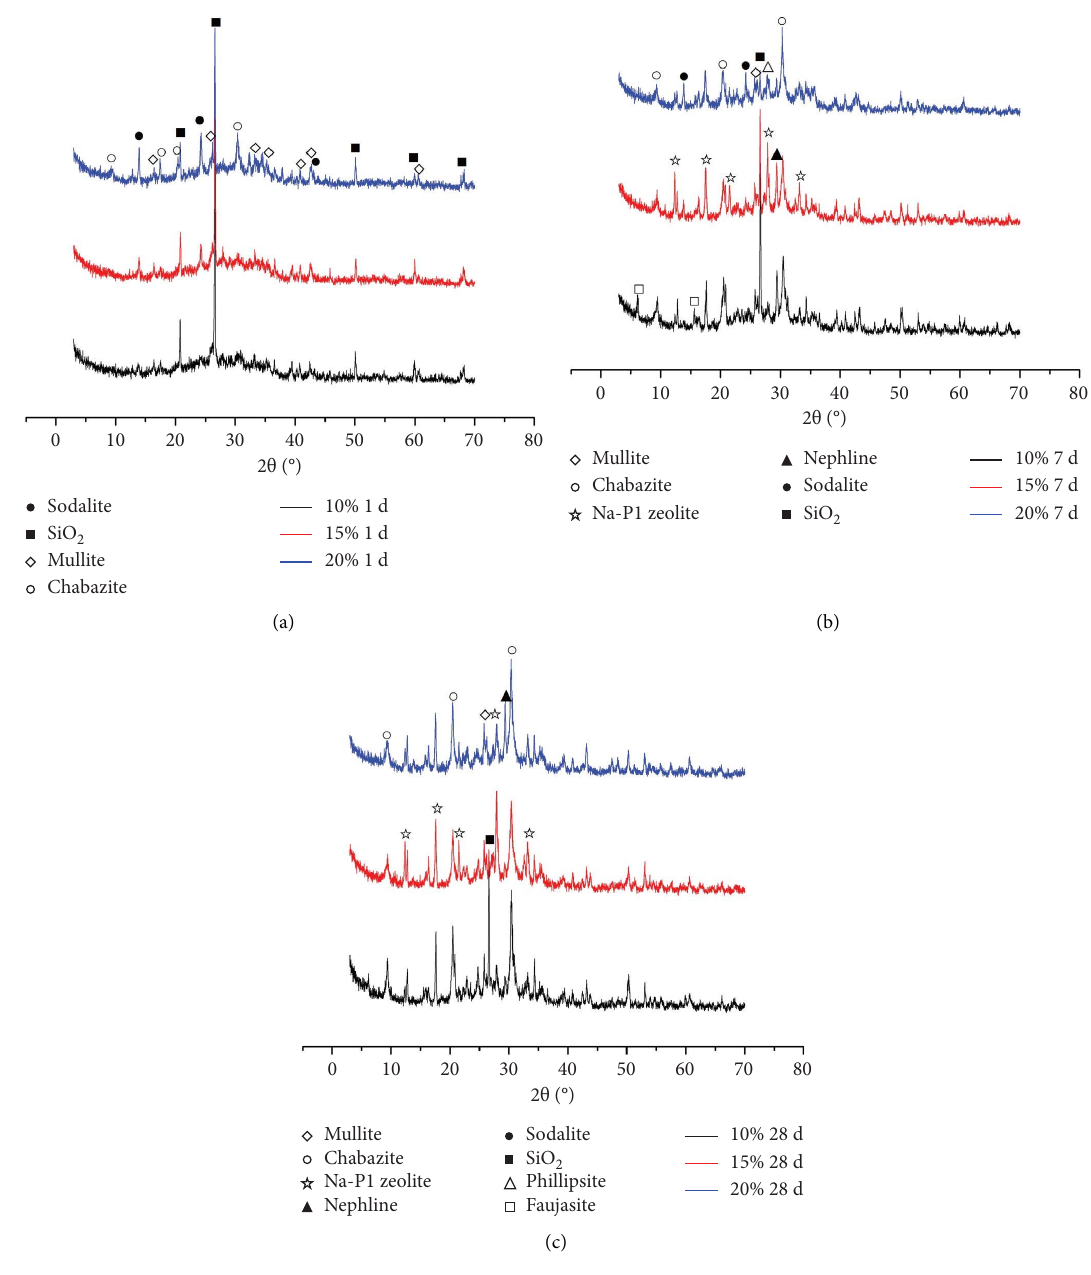
Figure 5: Te XRD patterns of FABG with diferent sodium hydroxide contents after curing at 90 ° C: (a) 1 d; (b) 7d; (c)